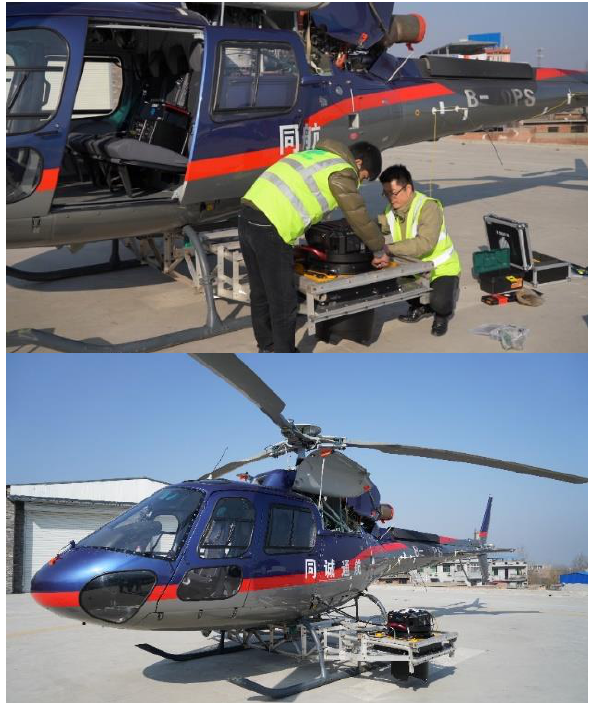
Figure 2.Implementation of aerial photography flight